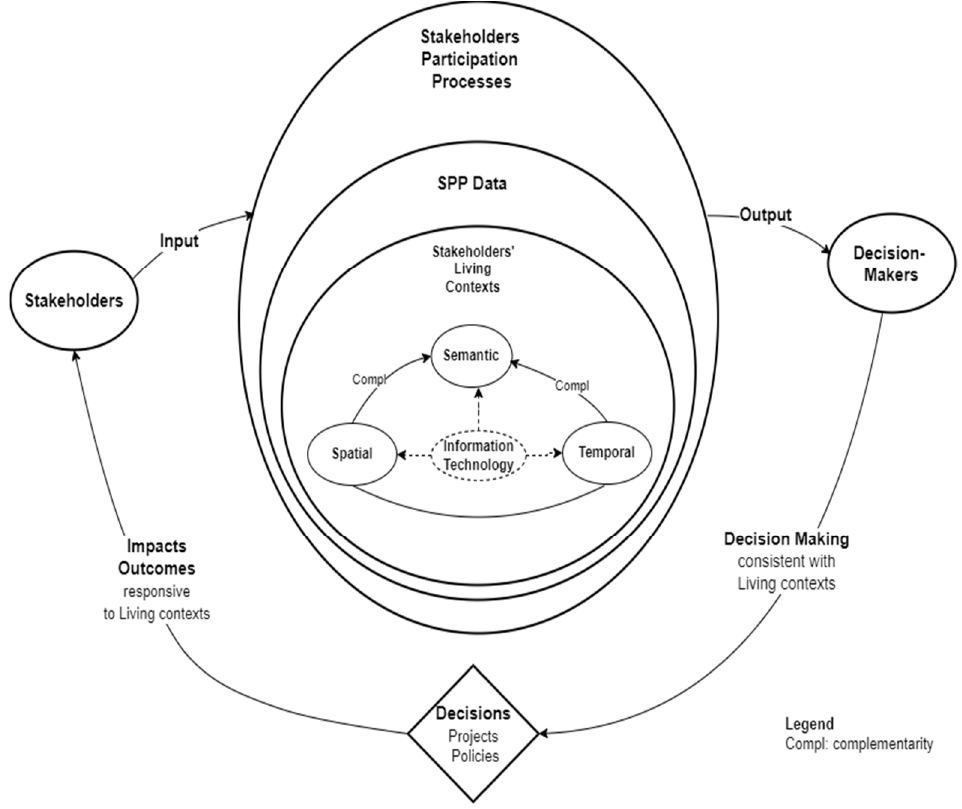
Figure 3. A conceptual model for the stakeholders’ living contexts identification in SPPs.